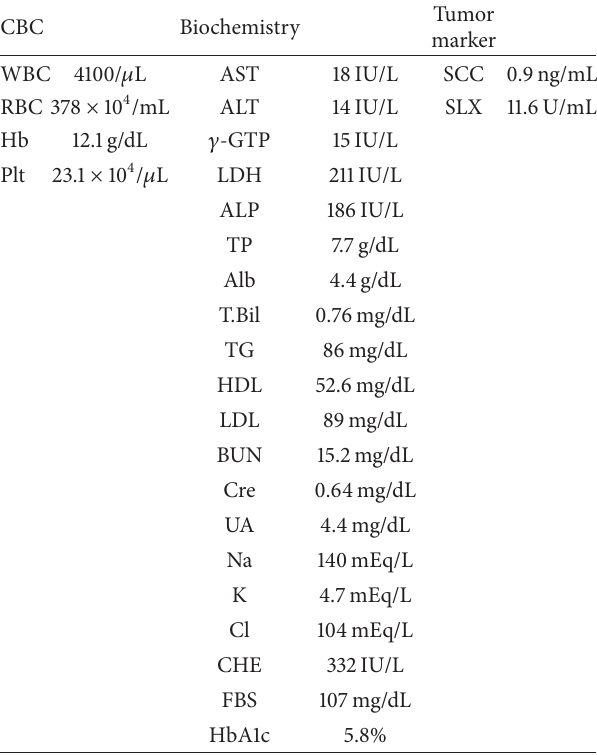
Table 1: Laboratory data at visitation. Laboratory data showed no